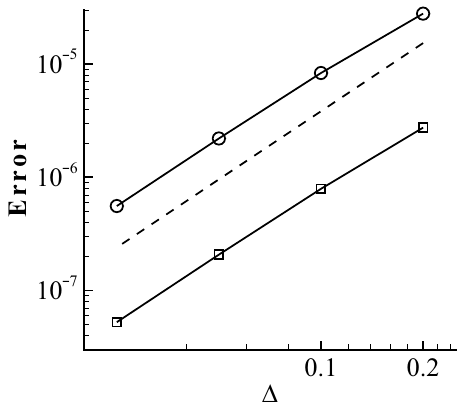
Figure 1. Error convergence study for a 2D propagating vortex. (cid:3) , L 2 error; (cid:13) , L ∞ error; , second-order